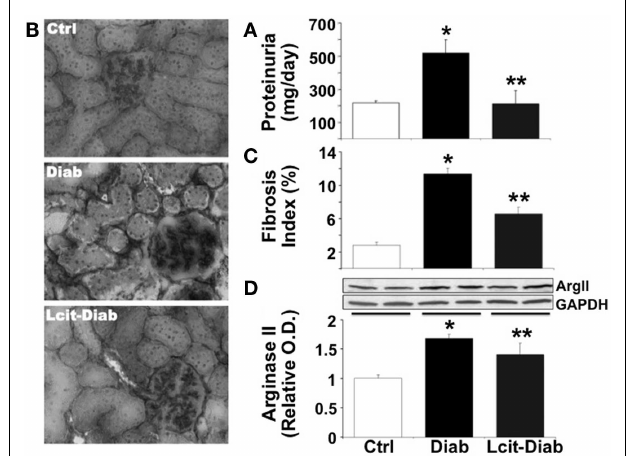
FIGURE 7 | Effect of l-cit on kidney pathology in STZ-rats . Urine and renal tissues from untreated control (Ctrl), untreated diabetic (Diab), and L -cit-treated diabetic (Lcit-Diab) rats were evaluated. (A) Rats were placed in metabolic cages for 24h urine collection.Total protein excretion was measured in urine. Lcit-Diab rats had a significant reduction of proteinuria when compared to Diab rats. * p < 0.05 vs. Ctrl, ** p < 0.05 vs. Diab. (B) Representative photomicrographs of frozen sections from rat kidneys stained with picro-sirius red, show enhanced collagen deposits (dark color, RGB image using Image J ) in untreated diabetic rats.This effect was markedly blunted in L -cit-treated diabetic rats. (C) Fibrosis index (%) of tissue collagen content that indicates the ratio of the mean picro-sirius red-stained area to the mean whole area of the section. * p < 0.001 vs. Ctrl, ** p < 0.001 vs. Diab. (D) Renal ArgII protein expression determined by densitometric analysis of immunoblots performed with protein extracts from rat kidney cortex ( n = 4, representative blot is shown). * p < 0.001 vs. Ctrl rats, ** p < 0.05 vs. Ctrl rats.